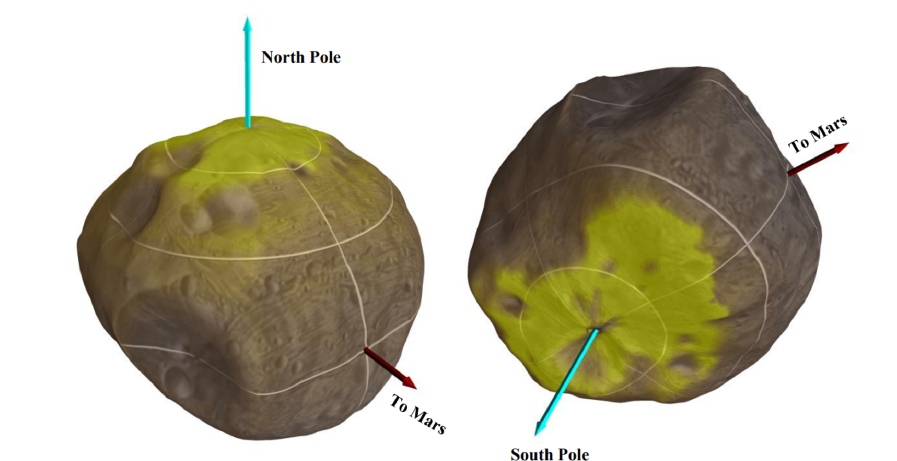
Figure 1. 3D Visualization of Phobos (Courtesy: Hopkins et. al. [41]). Regions in yellow face continuous sunlight and are the high priority targets for Phobos